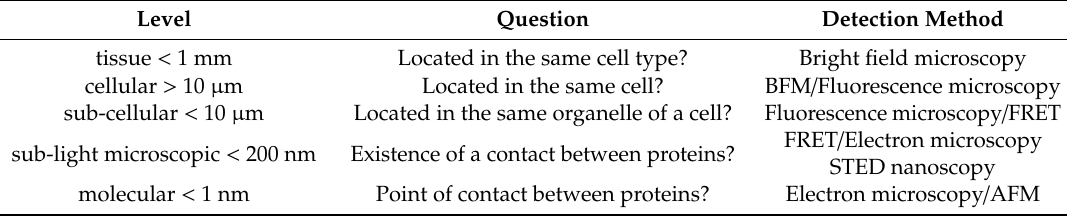
Figure 3. Principle of in situ detection of complex DNA damage via immunofluorescence, assuming the two DNA lesions are of type A and type B, respectively. The cell recruits DNA repair enzymes A and B (purple and salmon shapes) from DNA repair pathway A and B, respectively. Primary antibodies A and B (blue and grey) are specific against enzymes A and B, respectively. Similarly, secondary antibodies A and B (light blue and yellow) are specific against primary antibodies A and B, respectively. Secondary antibodies, upon appropriate stimulation, emit red and green signal, respectively. If the initial lesions A and B are located in close enough proximity, then the green and red fluorescence signals will be colocalized and detected collectively, which will appear as a yellow signal in a multicolor fluorescence image. By reversing this reasoning, the detection of colocalized signals implies the existence of complex DNA damage. Table 1. Colocalization at di ff erent levels of magnitude, and associated detection